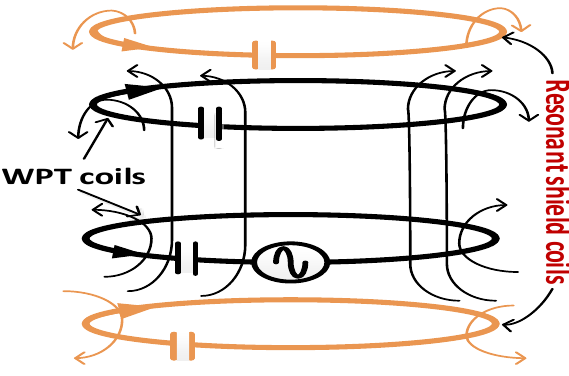
Figure 4. Resonant reactive current